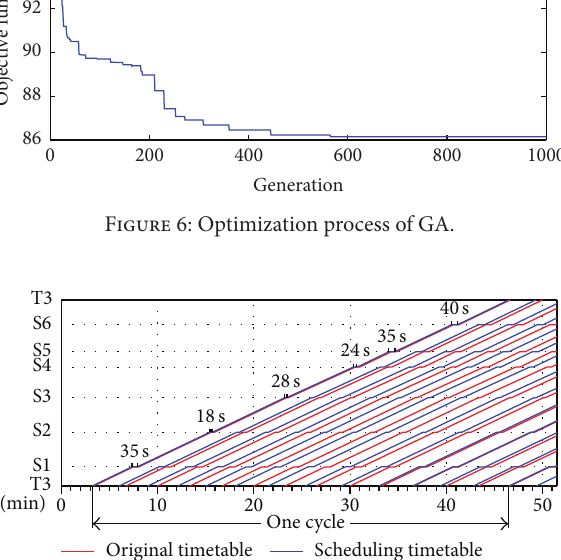
Figure 7: Original timetable and scheduling